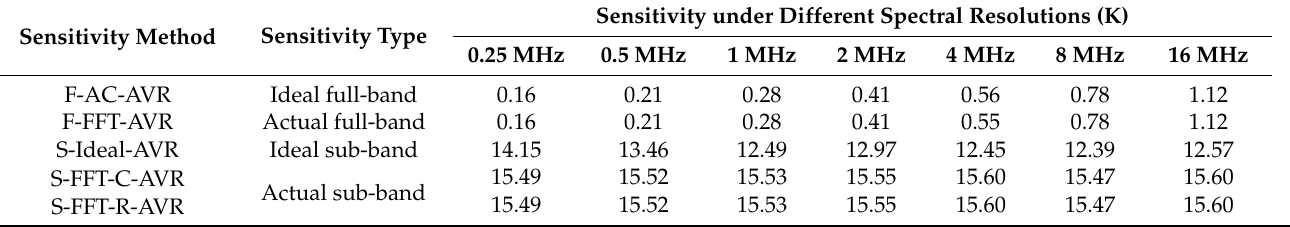
Figure 12. The sub-band sensitivity comparison and deterioration obtained by different integration time: ( a ) actual sub-band sensitivity and ideal sub-band sensitivity; ( b ) sub-band sensitivity deterioration ratio. Table 6. The average values of the sensitivity obtained by different spectral